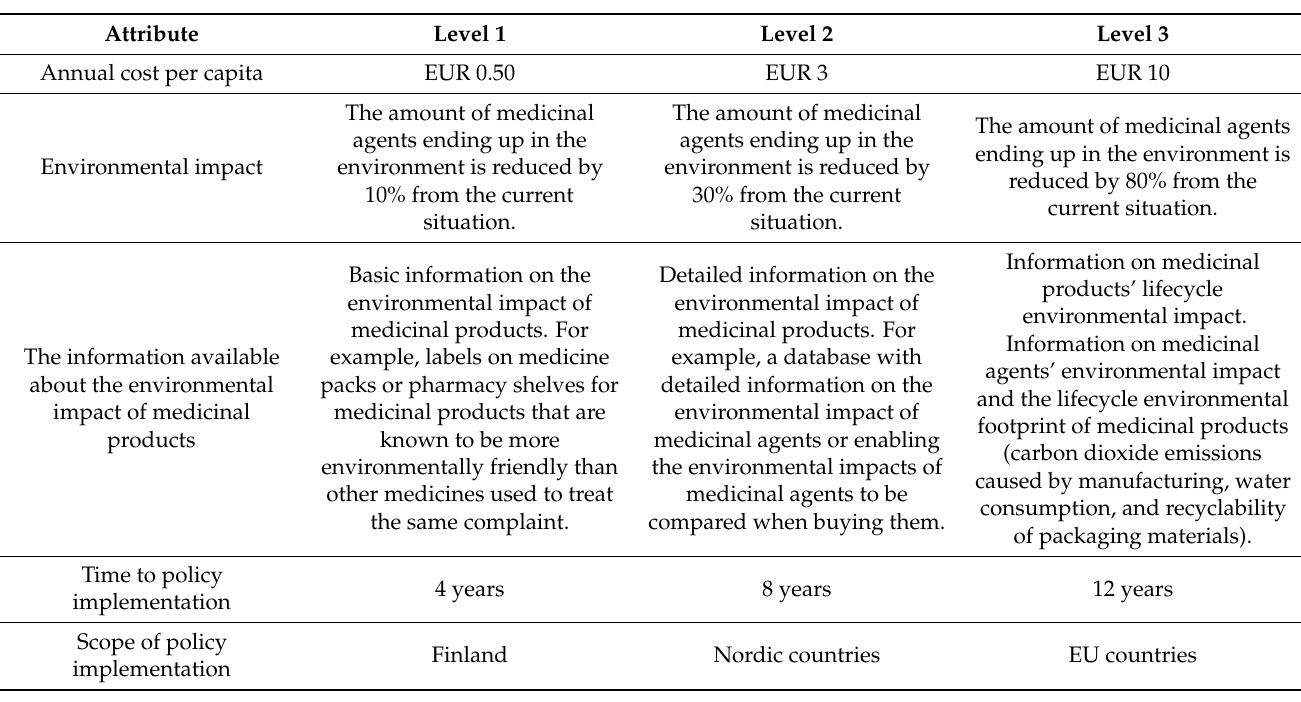
Table 1. Description of DCE attributes and